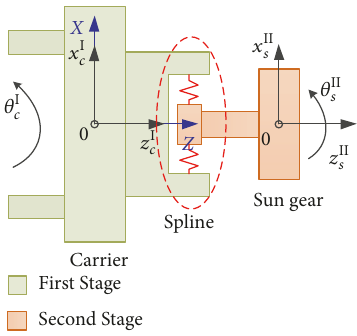
Figure 4: Schematic of the coupling relation of first-stage and second-stage.